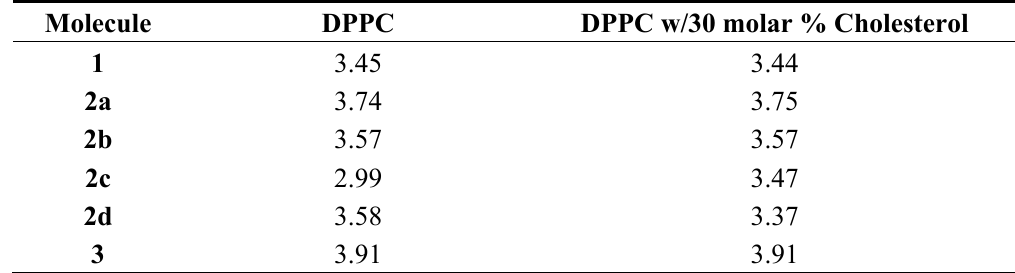
Table 3. Emission energies of the fluorescent probes within two different membrane environments calculated with QM/MM. All energies in